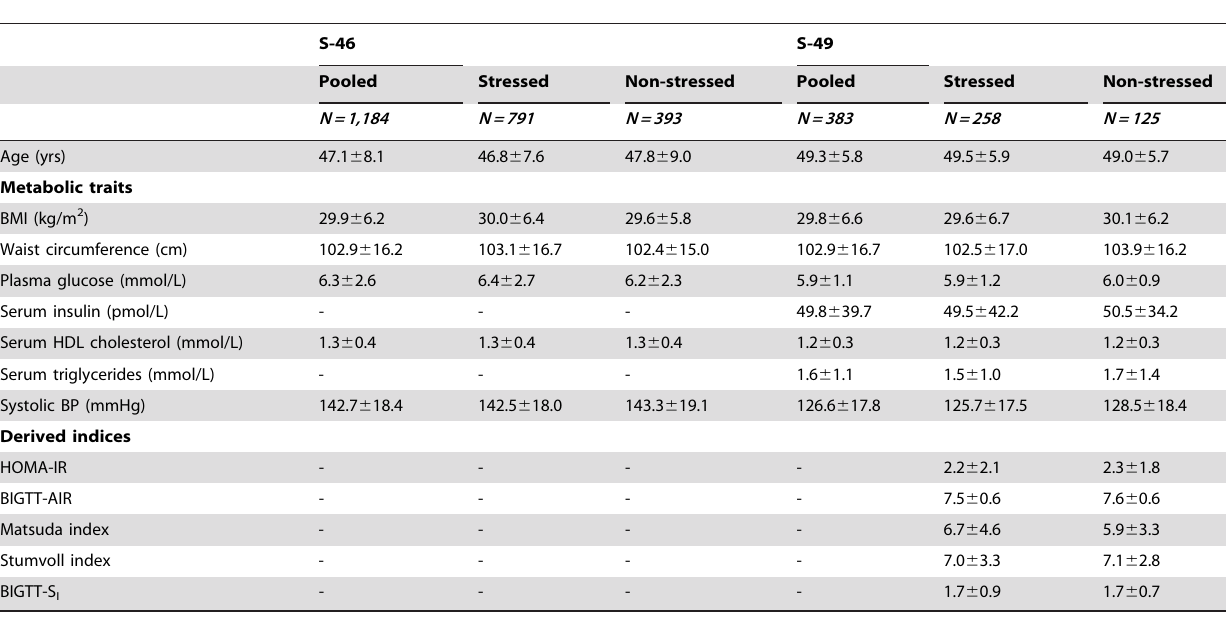
Table 3. Study population characteristic given as mean 6 SD by stress status at survey 46 (S-46) and survey 49 (S-49).